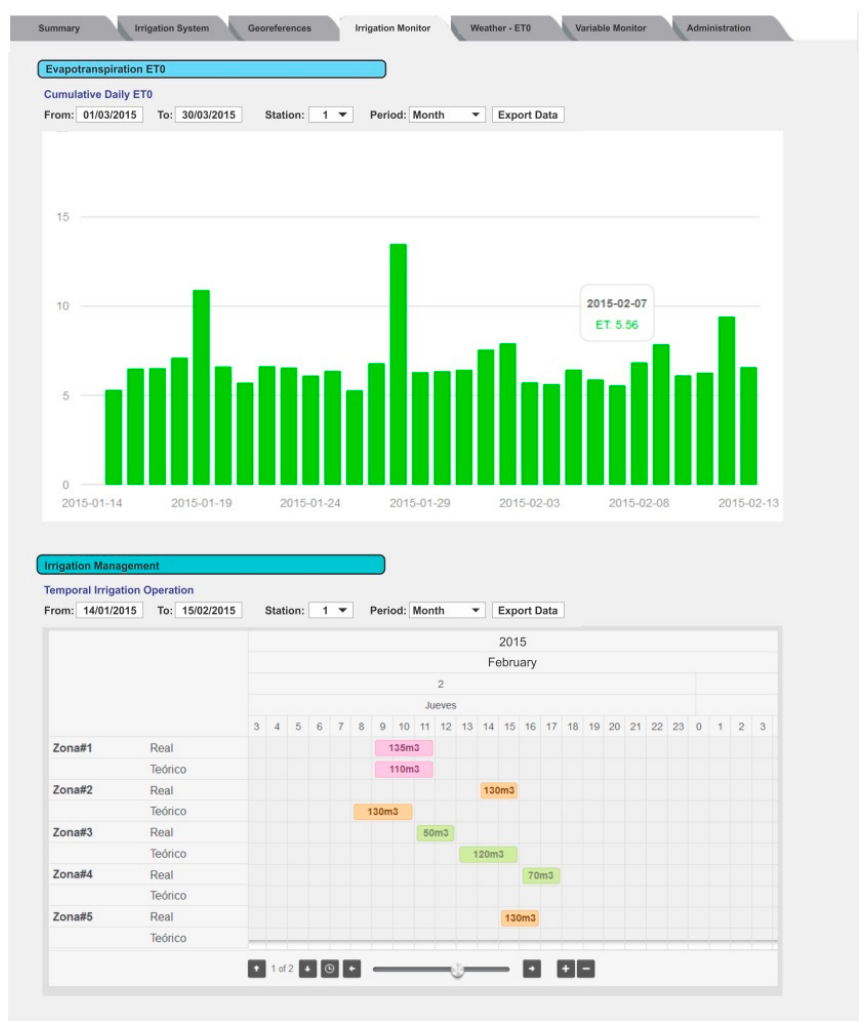
Figure 6. The Irrigation Monitor tab shows information related to the irrigation programming. The cumulative daily ET o and the irrigation shifts are also presented in this